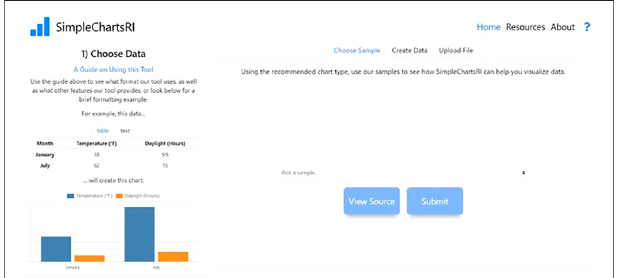
FIGURE 6 | simplechartsri.com select a chart step.